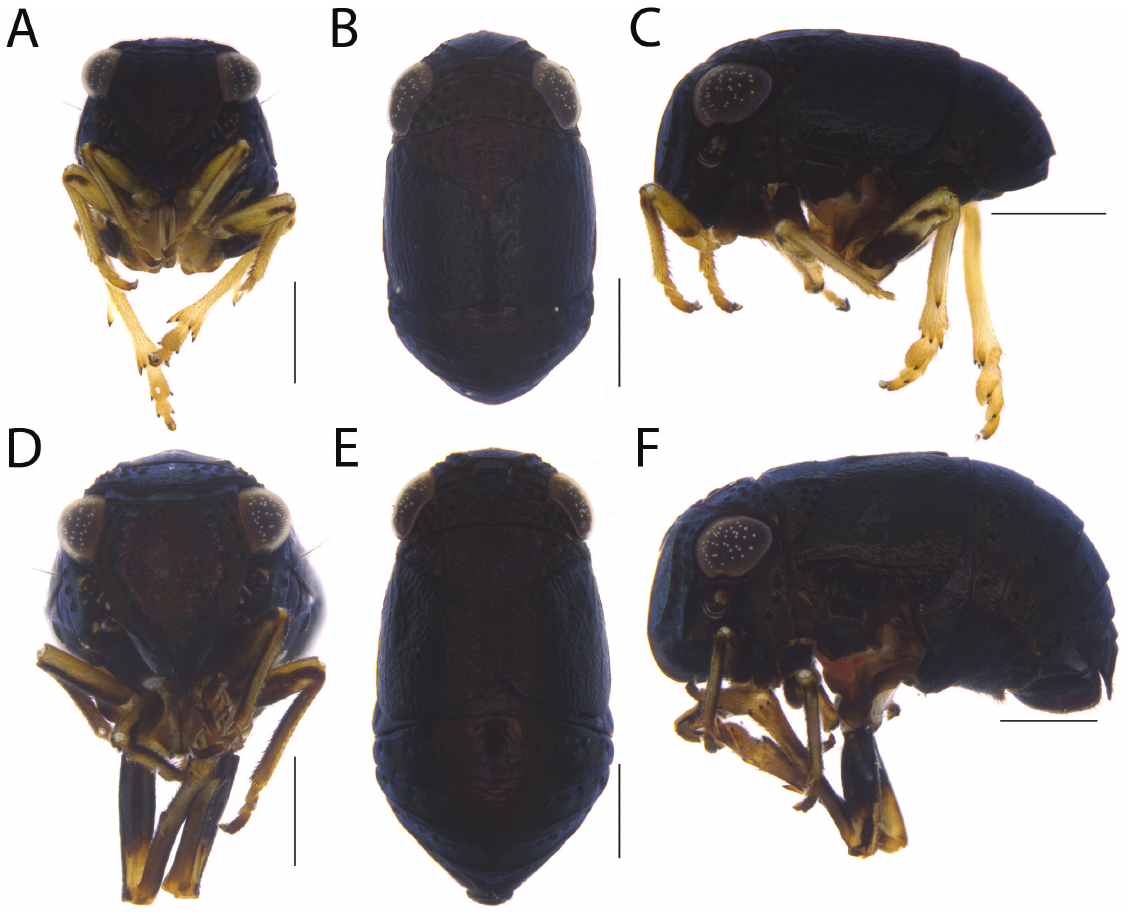
Fig. 6. Habitus of Bruchomorpha mormo Kirkaldy, 1907. A–C . ♂ (DZRJ). A . Frontal view. B . Dorsal view. C . Lateral view. D–F . ♀ (DZRJ). D . Frontal view. E . Dorsal view. F . Lateral view. Scale bars = 0.5